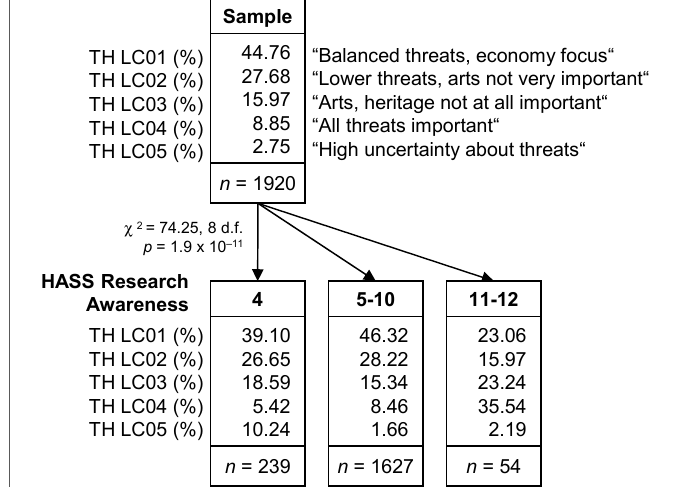
Figure 5. Threat-based sample segmentation (first level of the CHAID dendogram